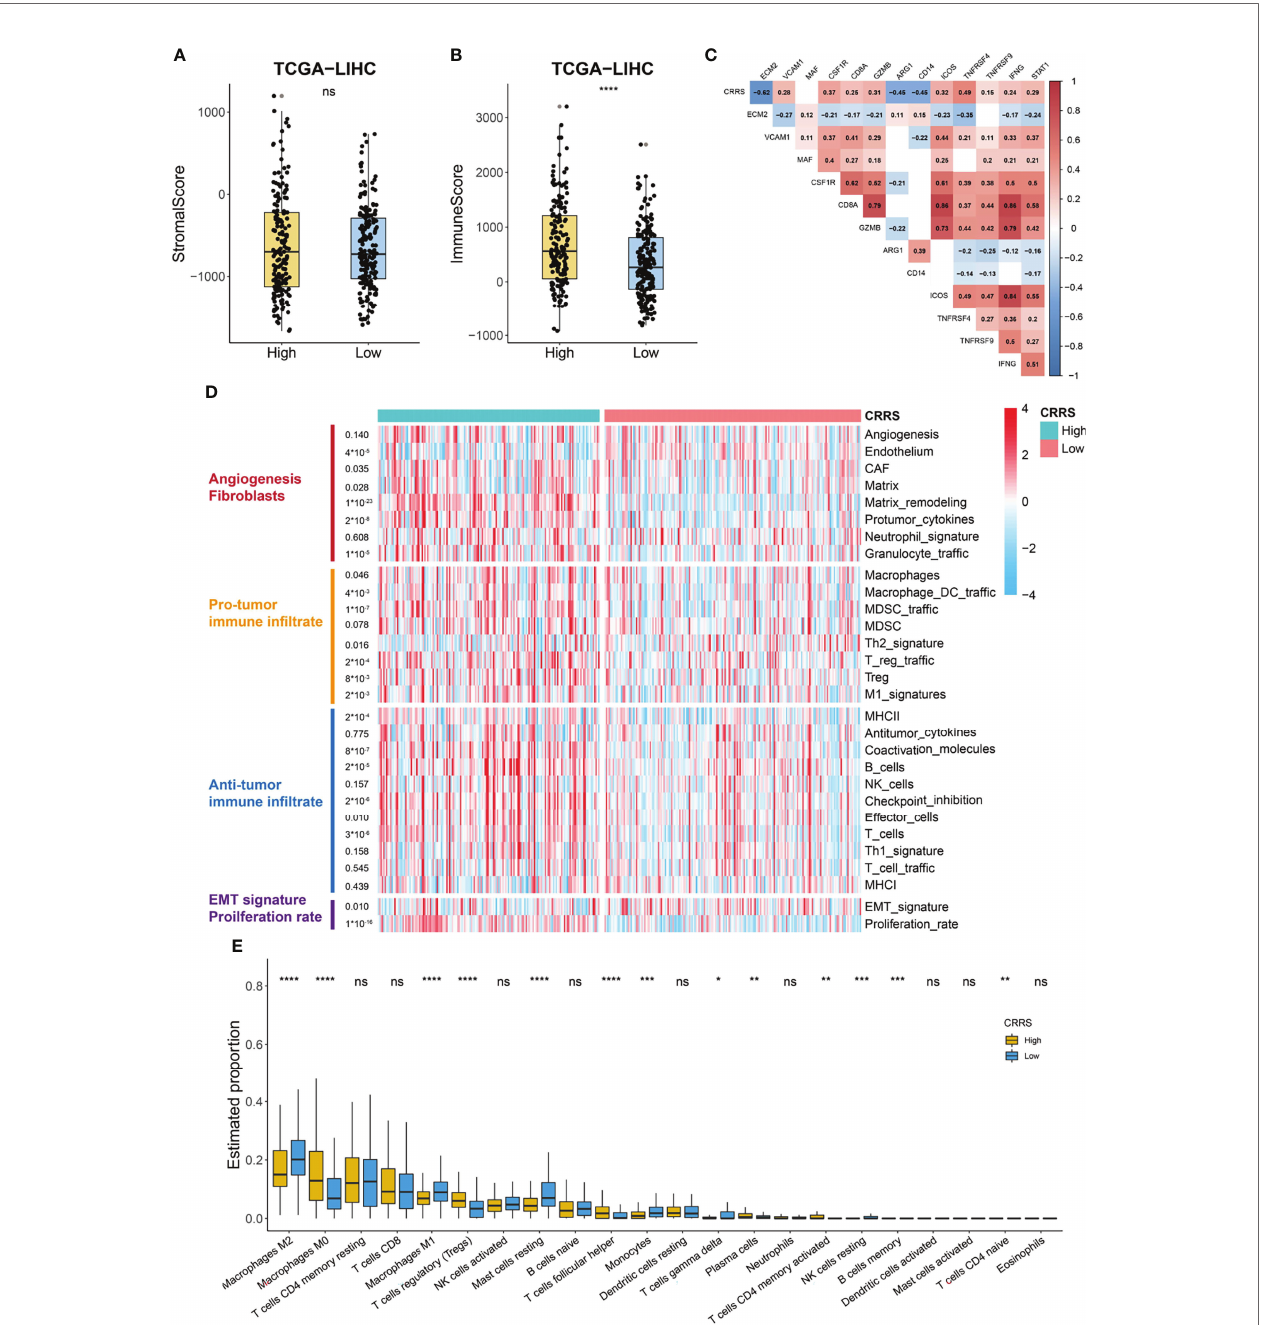
FIGURE 6 | Immune pro fi le of CRRS-based HCC groups. (A, B) Box and dot plot showing stromal score (A) and immune score (B) of HCC patients from high- and low-CRRS subgroups. Wilcoxon test was used for data analyses. (C) Association between CRRS and stroma or immune-related markers. Data were analyzed using Pearson correlation analysis. (D) Heatmap of the enrichment score of 29 Fregs in HCC patients from the low- or high-CRRS subgroups. (E) The boxplot showing the proportion of the 22 types of immune cells in HCC patients from the low- or high-CRRS subgroups. The p values were shown as *p < 0.05, **p < 0.01, ***p < 0.001, and ****p < 0.0001. ns for not signi fi